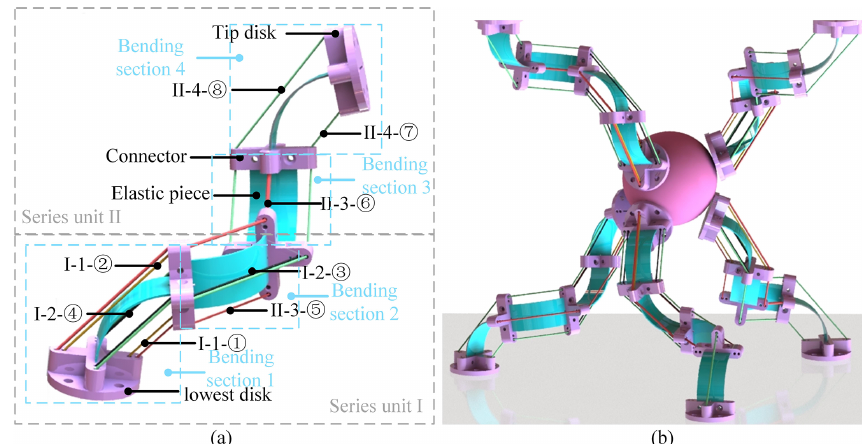
Figure 1. (a) Three-dimensional model of the continuum robot and its driving cable layout (I and II are the labels of each series unit; 1, 2, 3, and 4 are the labels of each bending section; and 1 (cid:13) to 8 (cid:13) are the labels of each cable). (b) The dexterous manipulation of the continuum robot.